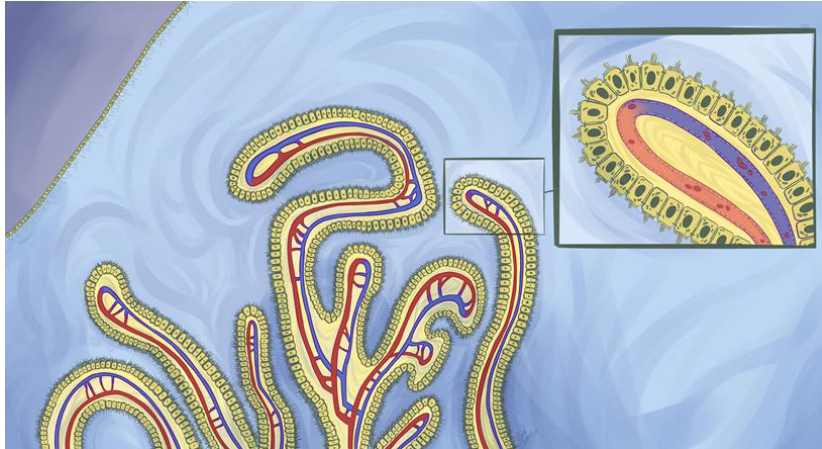
Figure 2. A choroid plexus suspended within a ventricle. The choroid plexuses are highly vascularized structures that house choroid plexus epithelial cells (CPECs). These cells are specialized ependymal cells that perform a variety of key functions within the central nervous system. CPECs are situated above fenestrated choroidal vessels that permit the rapid entry of fluid, solutes, and